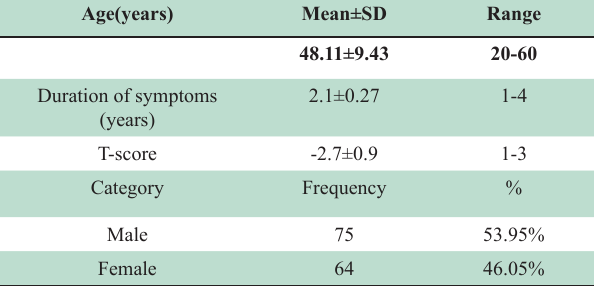
Table-I: Demographics (n= 139).